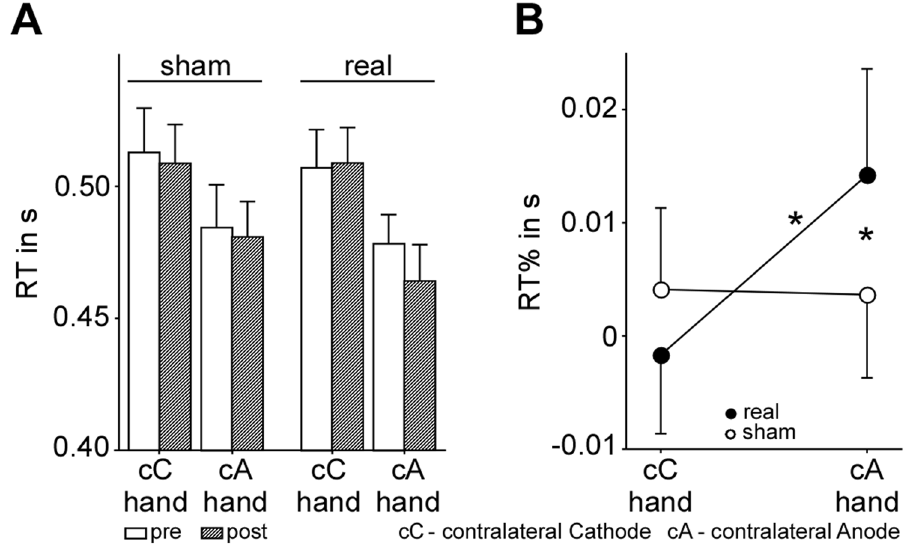
Figure 4. Descriptive and interferential statistics of stimulation-induced changes on behavioural level. ( A ) For the sake of transparency RTs of finger tapping before and after stimulation and subsequent MI practice before calculating the RT% (difference between RTs before and after stimulation) used for the main analysis is presented in this figure. Illustrated is the grand average RT for the hand contralateral to the cathode (cC hand) and the hand contralateral to the anode (cA hand) before (white) and after (grey) stimulation separately for sham and real stimulation conditions. Error bars represent one standard error. The anticipated difference between responses using the hand contralateral to the cathode (cC hand, left hand) and responses using the hand contralateral to the anode (cA hand, right hand) before stimulation is attributable to generally faster responses using the dominant right hand. ( B ) Interaction between stimulation type and hand considering the RT%. Error bars represent one standard error. * p <